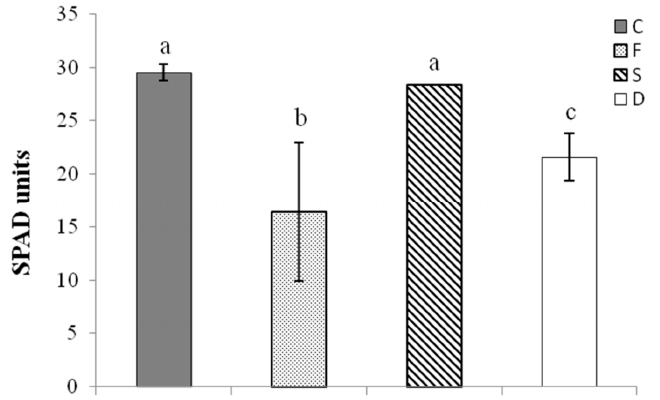
Figure 2. Chlorophyll content in tomato leaves. Changes in chlorophyll levels, evaluated as SPAD units, in leaves of tomato plants subjected to different nutritional treatments (C = control, F = Fe deficiency, S = S deficiency, D = dual deficiency). Data are means ± SD of six independent replicates run in triplicate. The statistical significance has been tested by a one-way ANOVA test with Tukey post-test. Significant differences between samples are indicated by different letters ( p < 0.01).